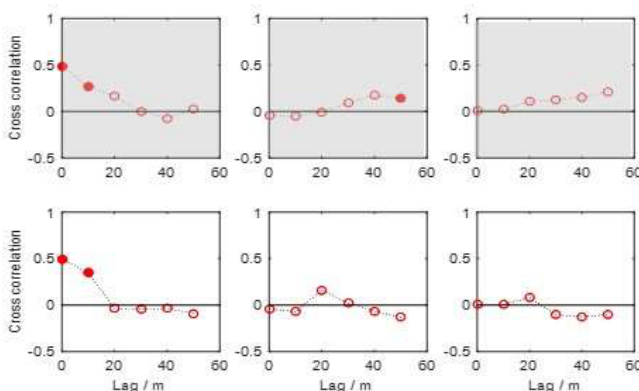
Figure 6. Cross-correlation of weed cover between years of the main weeds in the direct drilling fields (D). First row graphs: N–S direction, second row: E–W direction. Rows with grey background: direction of traffic. First column graphs: cross-correlation years 1 and 2, second column years 1 and 3 and third column years 2 and 3. Solid symbols mean that cross-correlation is significantly different from random.